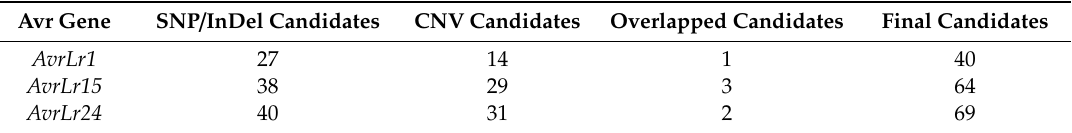
Table 5. Summary of candidates identified by single nucleotide polymorphism (SNP) / insertion / deletion (InDel) and CNV for AvrLr1 , AvrLr15, and AvrLr24. Avr Gene SNP / InDel Candidates CNV Candidates Overlapped Candidates Final Candidates AvrLr1 27